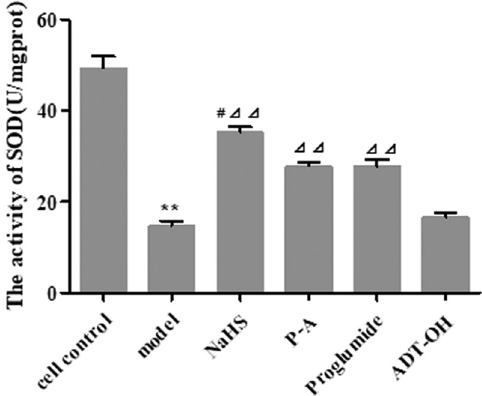
Figure 4: E ff ect of P - A acted on the activity of SOD in HUVEC damage model. ( Mean ± SD, n = 4 ) ** P < 0.01 vs cell control; ⊿⊿ P < 0.01 vs model; # P < 0.05 vs P -